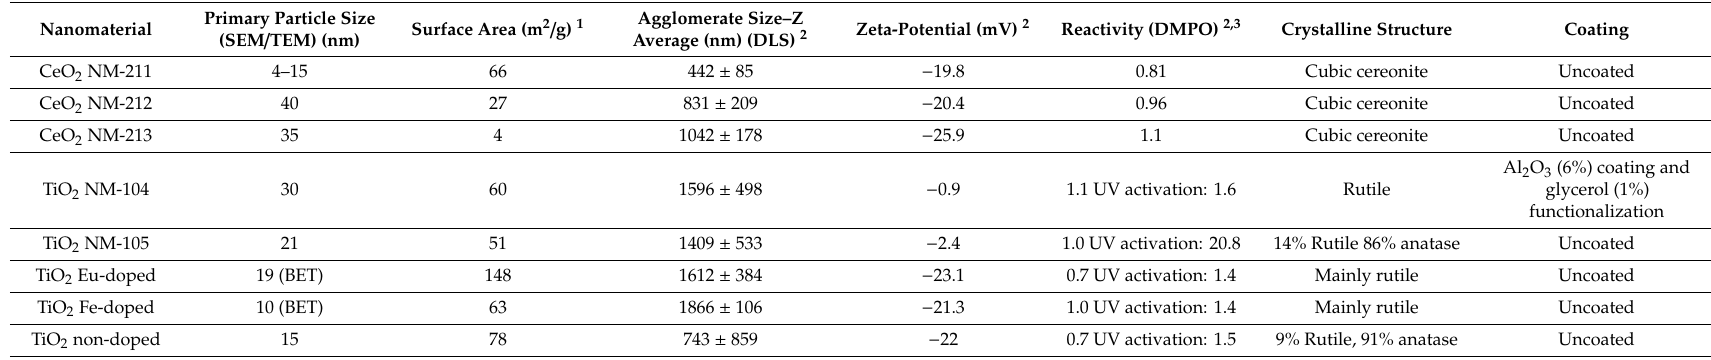
Table 1. Selected physicochemical characteristics of the eight engineered nanomaterials (ENMs) investigated in this study (for further details see the supporting information in two earlier publications